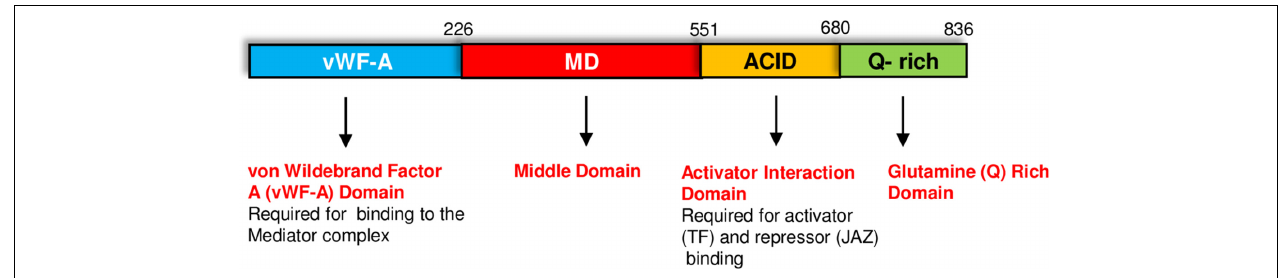
FIGURE 1 | The MED25 protein contains multiple domains. The Activator Interaction Domain (ACID) region interacts with MYC and other transcriptional regulators, while the conserved von Wildebrand Factor A (vWF-A) domain is required for the interaction of MED25 with the Mediator complex. Please see text for additional